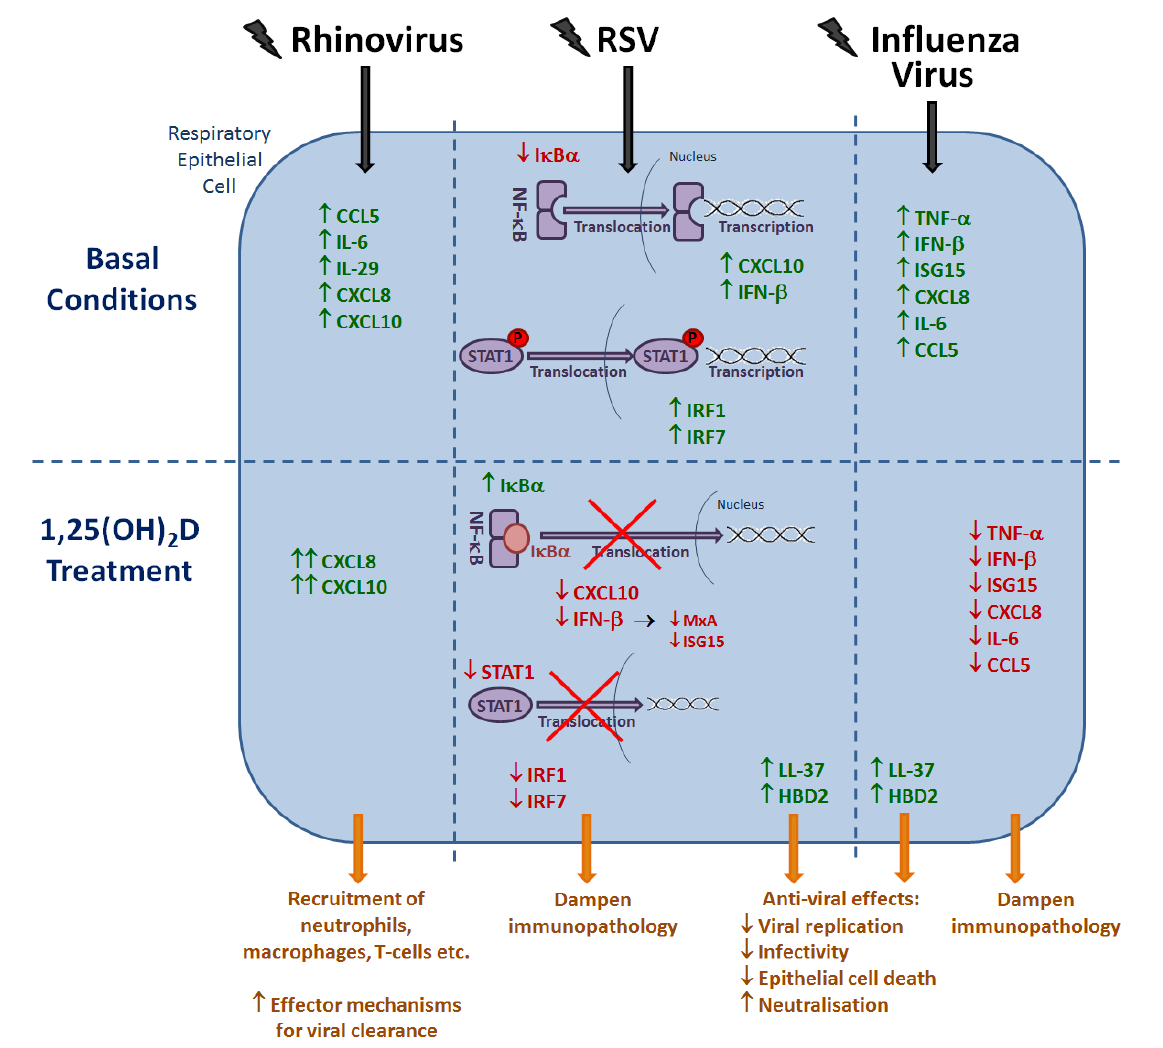
Figure 4. The immunomodulatory actions of 1,25(OH) 2 D against respiratory viruses. Rhinovirus infection of epithelial cells results in increased production and secretion of pro-inflammatory cytokines and chemokines, with the secretion of CXCL8 and CXCL10 further enhanced following treatment with 1,25(OH) 2 D. During RSV infection, IκBα expression is reduced, resulting in increased transcription of NF-κB-driven genes. STAT1 is also phosphorylated and able to translocate into the nucleus resulting in increased expression of IRF1 and IRF7. Pre-treatment with 1,25(OH) 2 D increases IκBα expression and decreases STAT1 phosphorylation, resulting in decreased production of CXCL10, IFN-β, MxA, ISG15, IRF1 and IRF7. Similarly, influenza A infection causes increased expression of pro-inflammatory cytokines and chemokines, with 1,25(OH) 2 D treatment causing decreased expression of TNF-α, IFN-β, ISG15, CXCL8, IL-6 and CCL5. Finally, 1,25(OH) 2 D is also able to increase LL-37 and HBD2 production, which have been shown to have antiviral effects against both RSV and